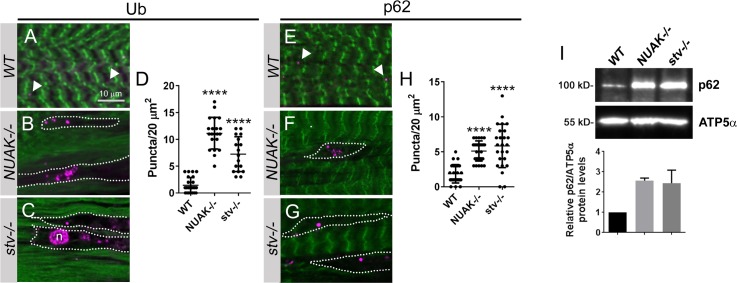
Autophagy is blocked upon loss of the NUAK-Stv complex.(A-C,E-G) Anti-Ub (A-C) or anti-p62 (E-G) immunostaining (purple) in L3 muscle tissue (green, F-actin). (A) Ub-(+) puncta (white arrowheads) are occasionally present in WT muscle. (B,C) Puncta that stain positive for Ub are clustered in areas of the muscle where F-actin is excluded (white dotted outlines) in NUAK-/- (B) or stv-/- (C). (D) Scatter plot depicting the number of Ub(+) puncta/20 um2. (E) Similar to Ub, puncta corresponding to p62 (white arrowheads) are found in normal muscle tissue. (F,G) p62(+) puncta are present in greater numbers upon loss of NUAK (F) or Stv (G). (H) Quantitation of p62(+) puncta/20 um2 depicted by a scatter plot. (I) Western blot of whole L3 larvae reveals a block in autophagy indicated by elevated p62 protein levels in NUAK or stv mutants. ATP5α is used as a loading control. Bar graph depicts the ratio of p62/ ATP5α intensity in the indicated genotypes. N = 3. (Mean +/- SEM. (*, p<0.05). Mean +/- SEM. (****, p<0.001).